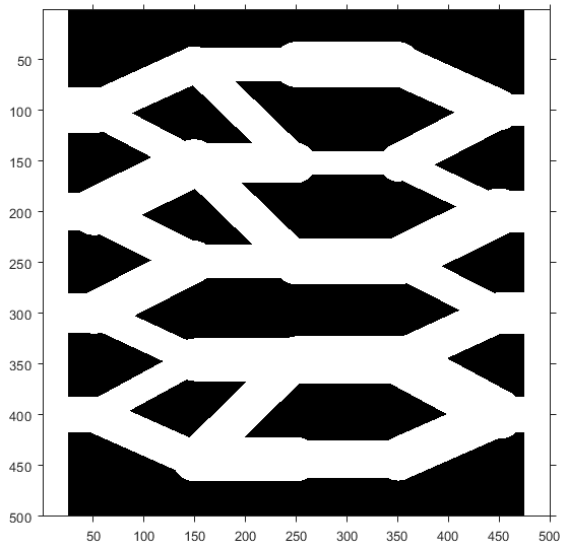
Figure A2. Simulation domain D3, which includes a complex network of channels.